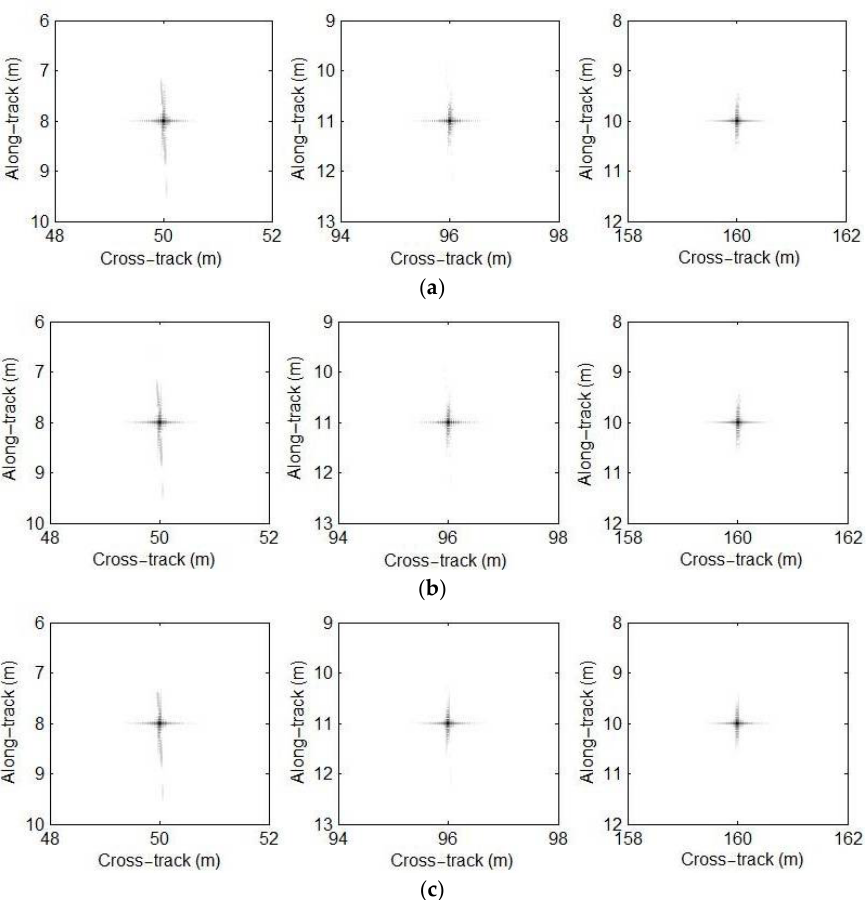
Figure 14. Imaging results with the case of a narrow-bandwidth signal. ( a ) Traditional method; ( b ) presented method; ( c ) BP algorithm. ( b ) presented method; ( c ) BP